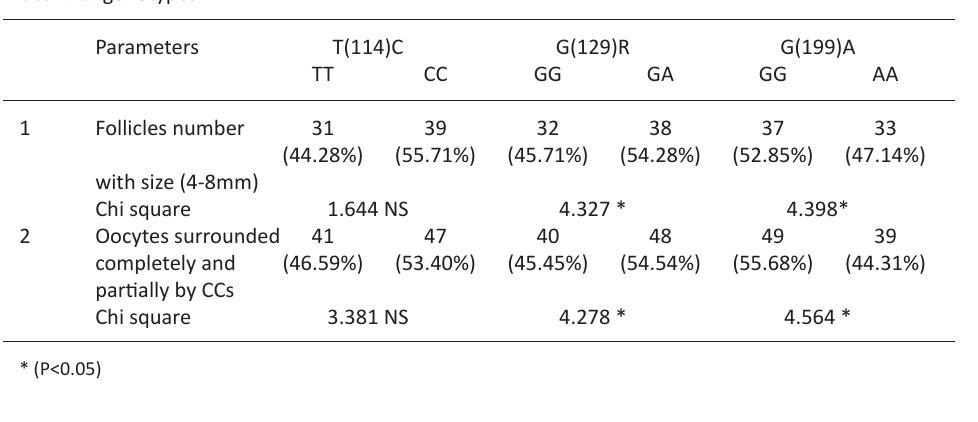
Table 4. Comparative between number and percentage of follicles and oocytes that surrounded by CCs with genotypes